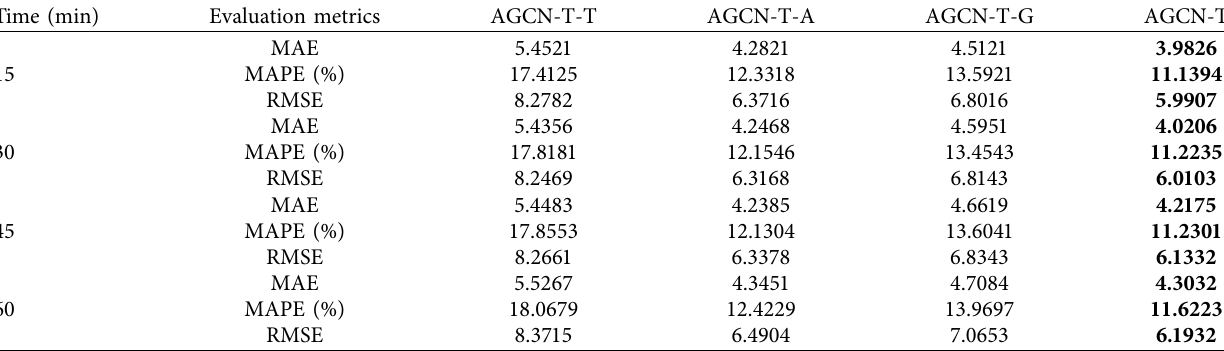
Table 7: Performance of variants of AGCN-T on Seattle.